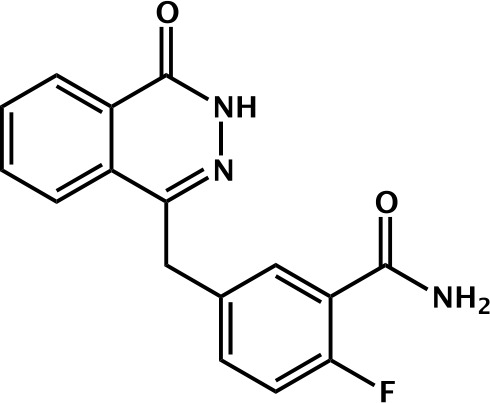
2-fluoro-5-((4-oxo-3,4-dihydrophthalazin-1-yl)methyl)benzamide.2-fluoro-5-((4-oxo-3,4-dihydrophthalazin-1-yl)methyl)benzoic acid (50 mg, 0.17 mmol) was added to a flame dried flask and dissolved in SOCl2 (20 ml) and refluxed at 80 °C for 45 min. The reaction mixture was cooled to 0 °C and then added dropwise to ice cold anhydrous NH3/MeOH (7 N, 100 ml). White solids quickly precipitated from an orange solution accompanied by rapid heating of the reaction vessel and smoke. The reaction was left to stir over night and the product collected as a solid by vacuum filtration: 50 mg (100%).